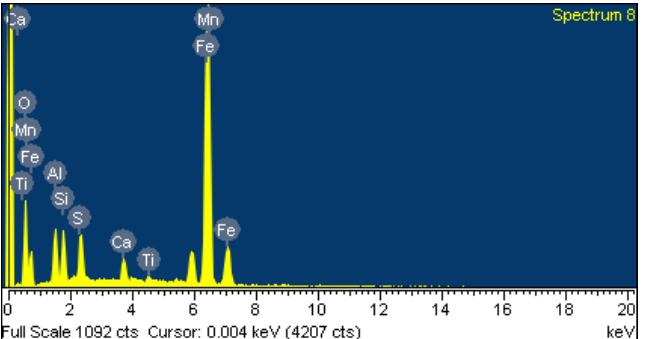
Figure 7. EDX spectrum of an inclusion containing several chemical elements.